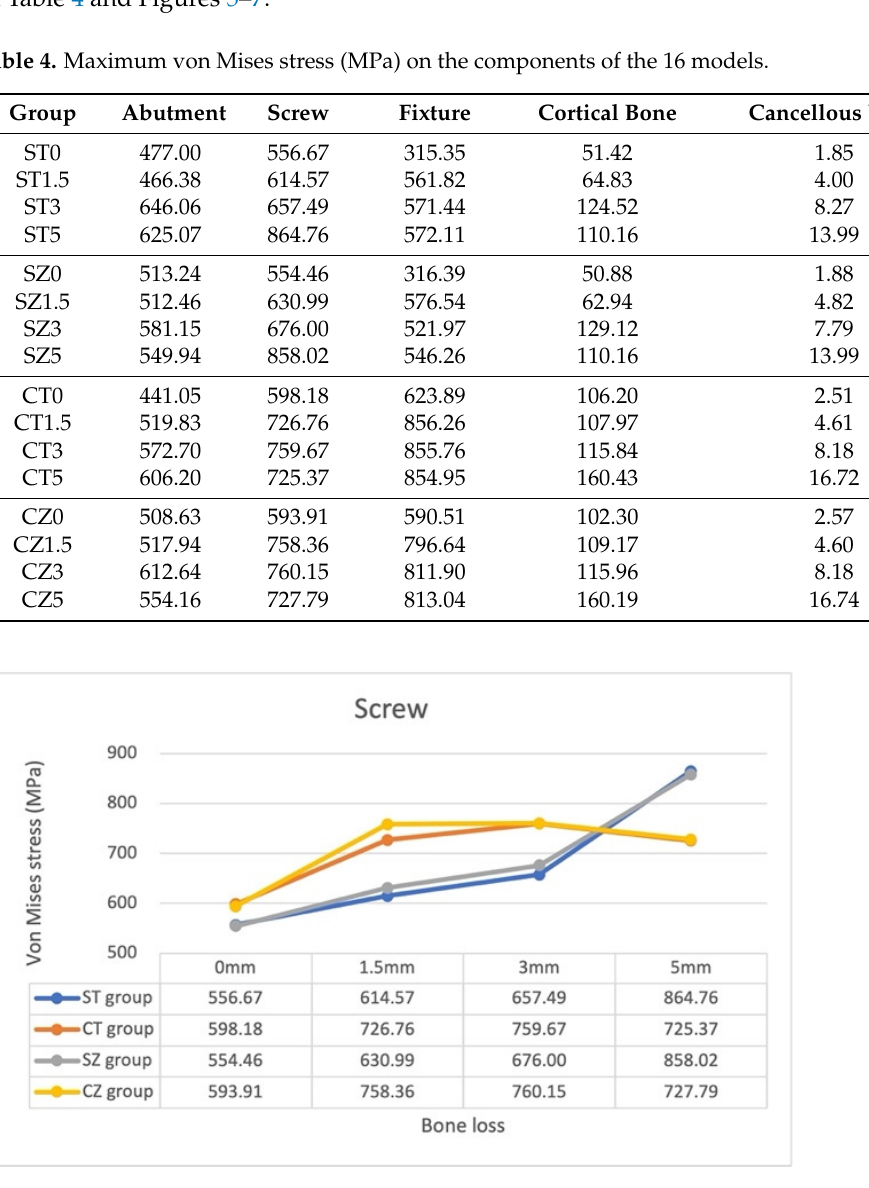
Figure 5. Maximum von Mises stress on the screw of the 16 models.